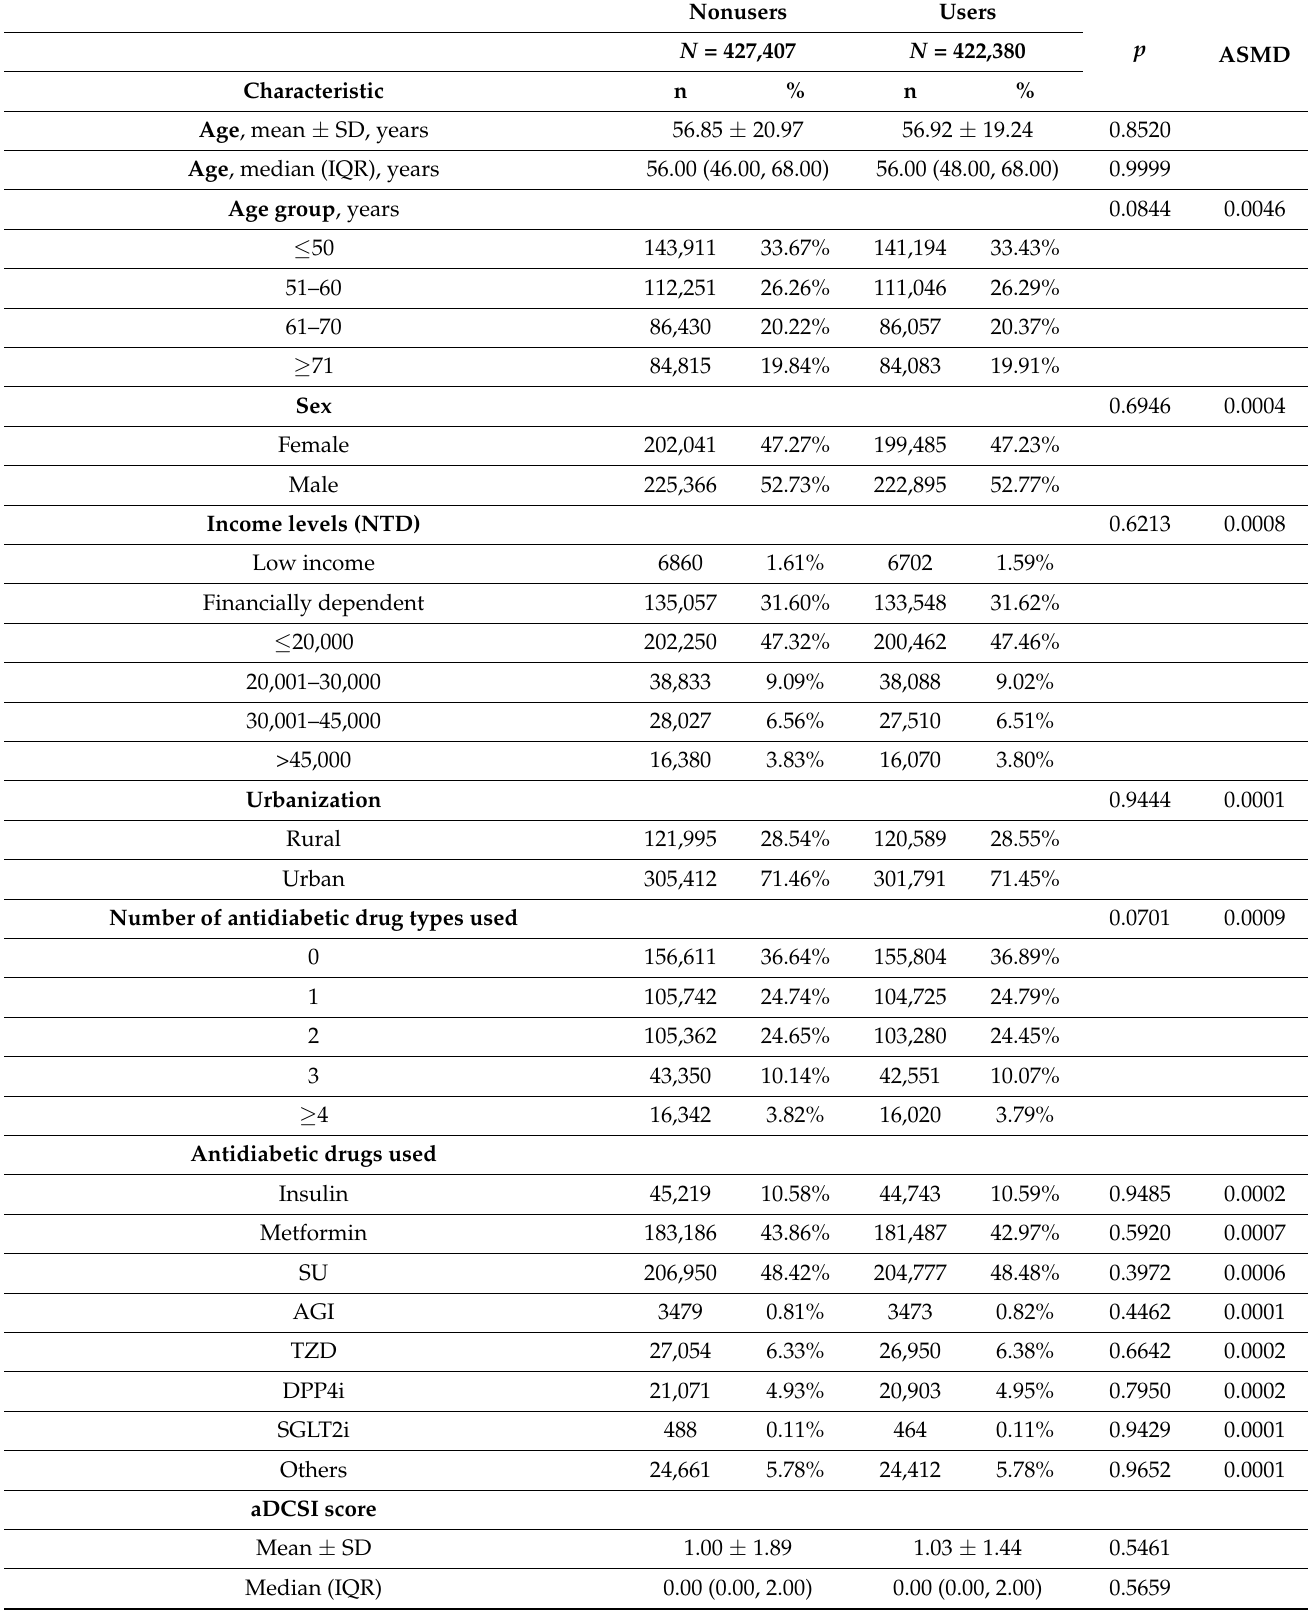
Table 1. Baseline characteristics of type 2 diabetes cohort: overall and stratified by statin